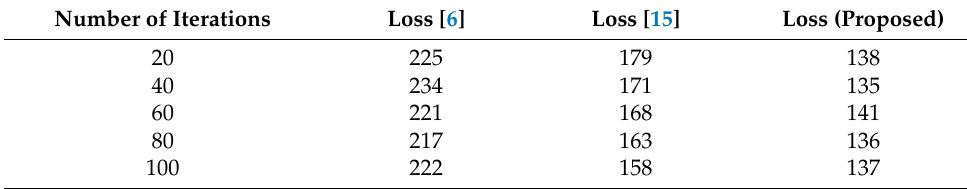
Figure 5. Association of loss function at minimized process. Table 4. Comparison of loss